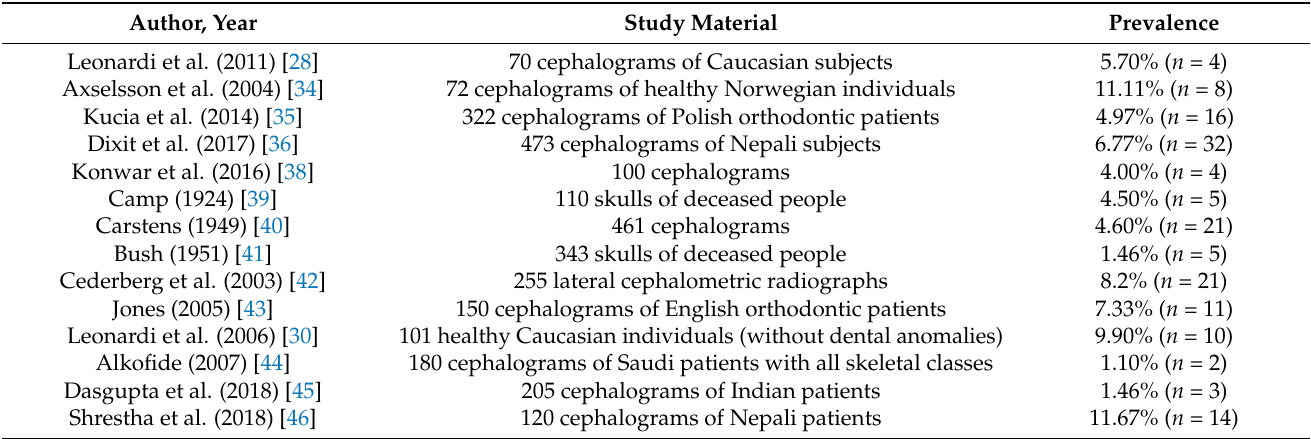
Table 4. Prevalence of complete sella turcica bridge in healthy individuals (in chronological order from earliest to most recent).